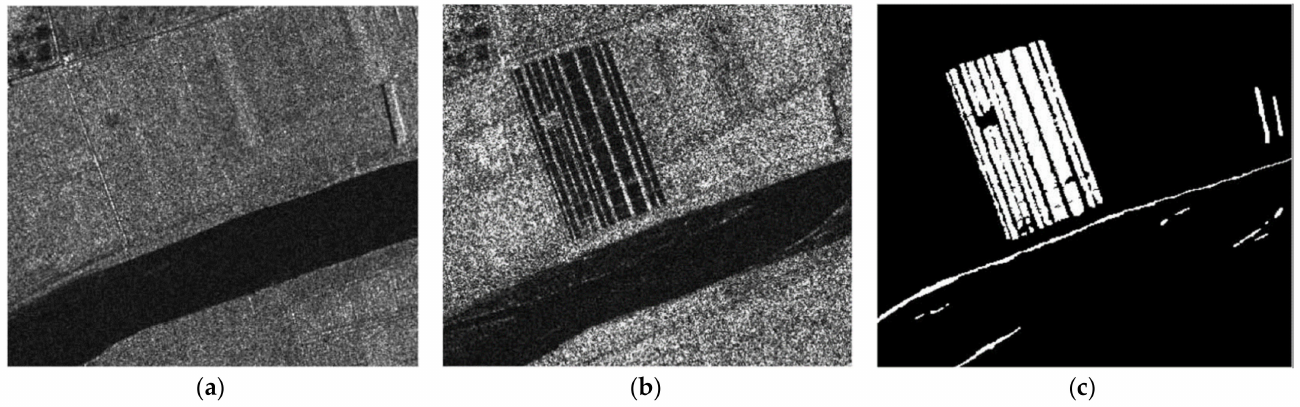
Figure 6. Multi-temporal SAR images of Yellow River Estuary in China. ( a ) SAR image acquired in June 2008. ( b ) SAR image acquired in June 2009. ( c ) The reference map, called ground